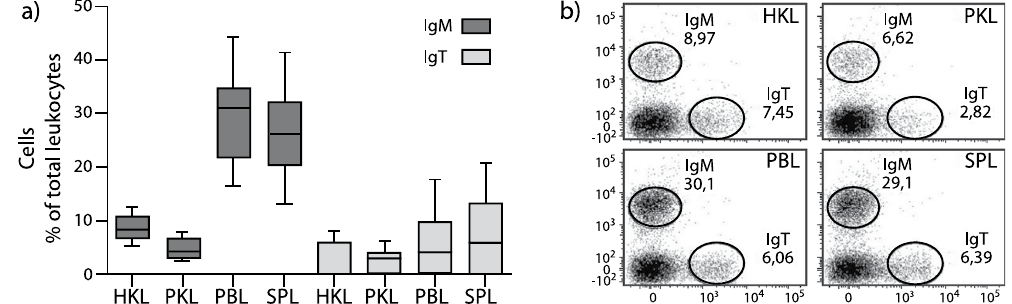
Figure 1. IgM + cells are the dominating B cell population in Atlantic salmon systemic lymphoid tissues. Flow cytometry analysis of Atlantic salmon head kidney (HKL), posterior kidney (PKL), peripheral blood (PBL) and spleen (SPL) leukocytes stained with trout anti-IgM and IgT mAbs. ( a ) Median frequencies of IgM + and IgT + B cells of total leukocytes (n = 12). The box indicates 25 th and 75 th percentiles and the bars min and max values. ( b ) Representative flow cytometry dot plots showing the IgM and IgT percentages in the systemic lymphoid